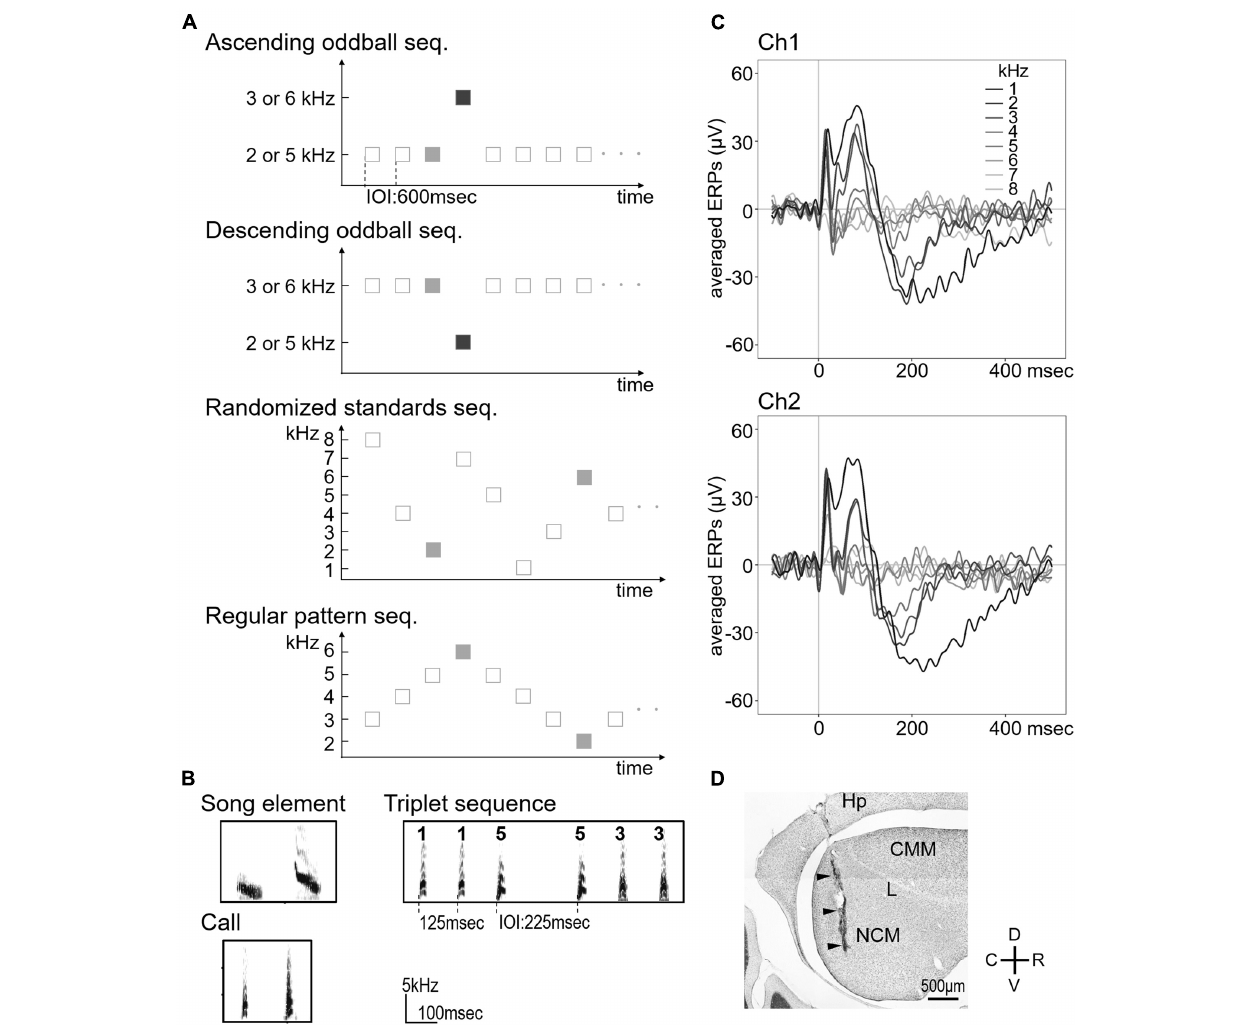
FIGURE 1 | Sequence designs used in the passive auditory paradigm and averaged event-related potentials (ERPs) to pure tones. (A) Schematic diagram of the oddball paradigm. Deviant stimuli (dark gray squares) were presented randomly in ascending and descending oddball sequences. Light gray squares indicate standard/control stimuli to be analyzed for neural responses. (B) Sound spectrograms of the song elements and contact calls used as auditory stimuli (left). Examples of the triplets used in the triplet sequence (right). (C) Averaged ERPs were recorded from each hemisphere in response to the randomized standard sequence ( n = 7, 1–8 kHz presented at an equal probability of p = 0.125). There was no significant difference in ERPs between the two channels in all experiments. (D) Representative Nissl-stained parasagittal section showing the location of the electrode. ERP, event-related potential; Hp, hippocampus; CMM,